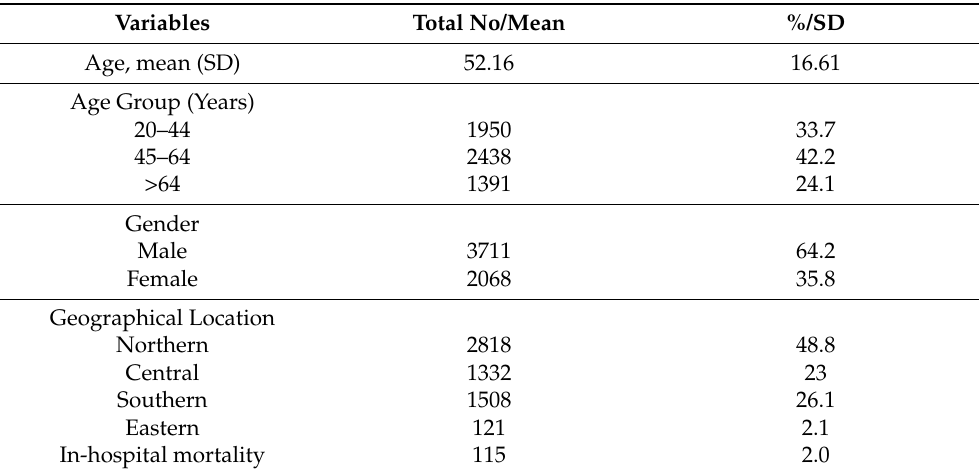
Table 1. Demographic characteristics of 5779 patients diagnosed with parapharyngeal and retropha- ryngeal abscess (PRPA) in Taiwan during